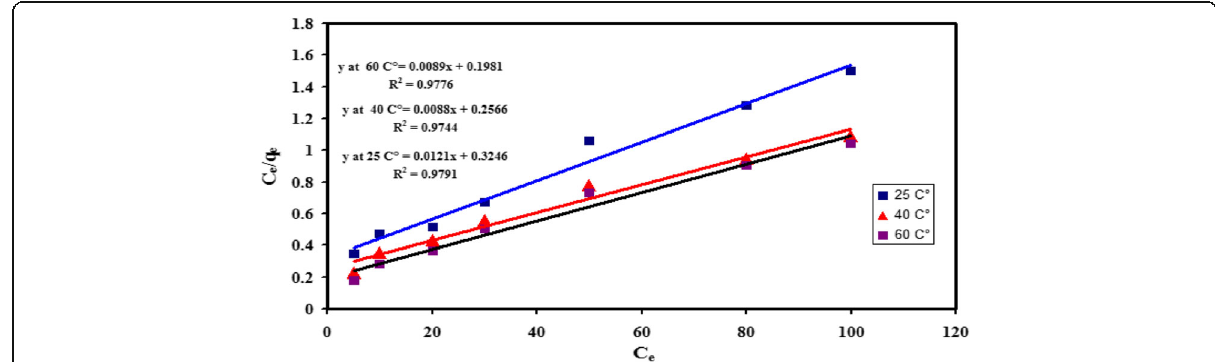
Fig. 16 Langmuir isotherm model plot of AO67 onto RPSF